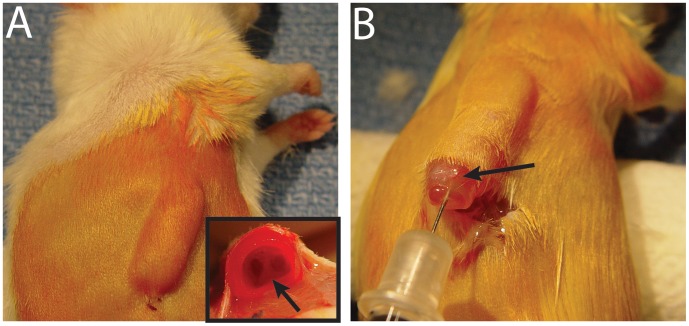
Human fetal trachea xenografts: Human fetal trachea xenografts 4 weeks after subcutaneous implantation in the SCID mice.A) Fetal trachea xenograft model. Inset demonstrates the biopsied cross sectional view of the xenograft with visible carina (arrow) at four weeks after subcutaneous implantation in a SCID mouse. (B) At four weeks after implantation, an operculum is formed over the trachea opening; xenografts produce mucous and are well vascularized (arrow). A microsyringe is inserted through the operculum to extract mucus and inject AAV vectors into the lumen of the xenografts.